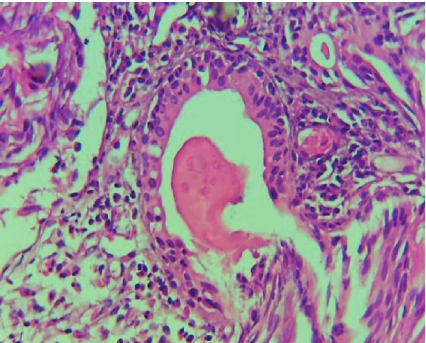
Figure 6: Dysplastic lesion associated with granulomatous in- flammatory reaction due to Schistosoma haematobium . Hema- toxylin and eosin x 100 (image of Professor Dial, head of the pathological anatomy laboratory of